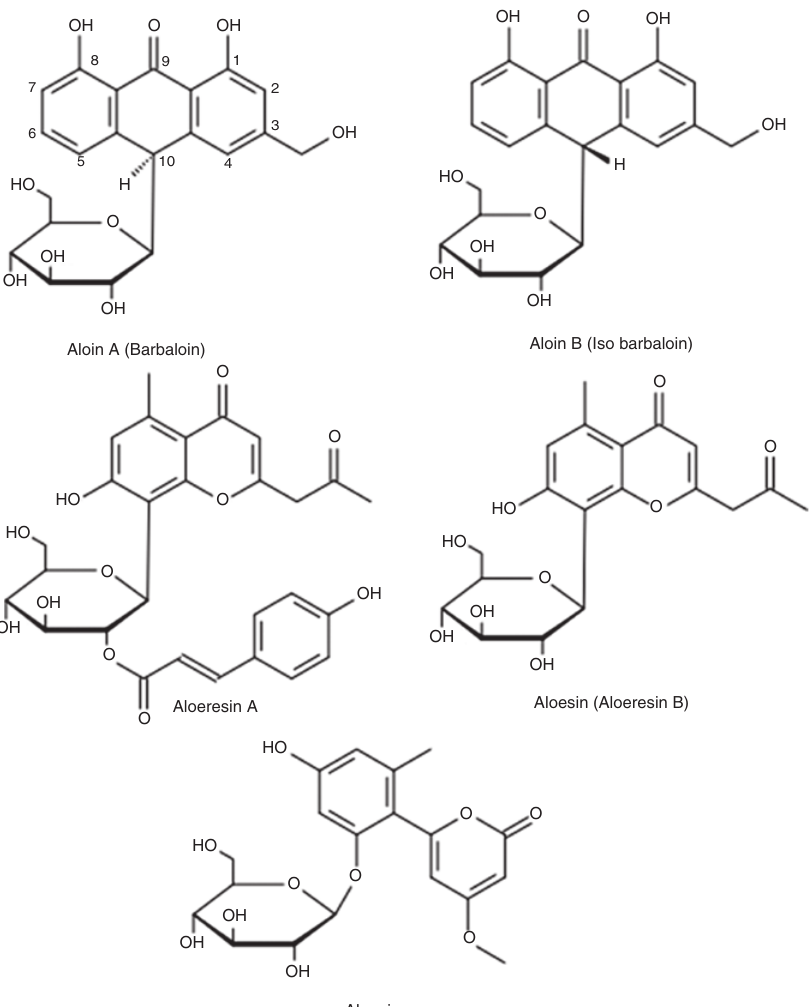
Figure 4: Chemicals present in latex prepared from Aloe vera